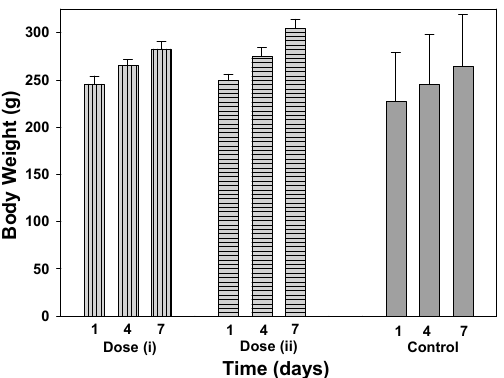
Figure 7. Comparison of animal body weights treated with 12 at doses of (i) 14 mg/kg (2 mg/kg per day for 7 days) (grey bars, vertical lines), (ii) 10 mg/kg (grey bars horizontal lines) and PBS control (solid grey bars) on days 1, 4 and 7 ( n = 3).